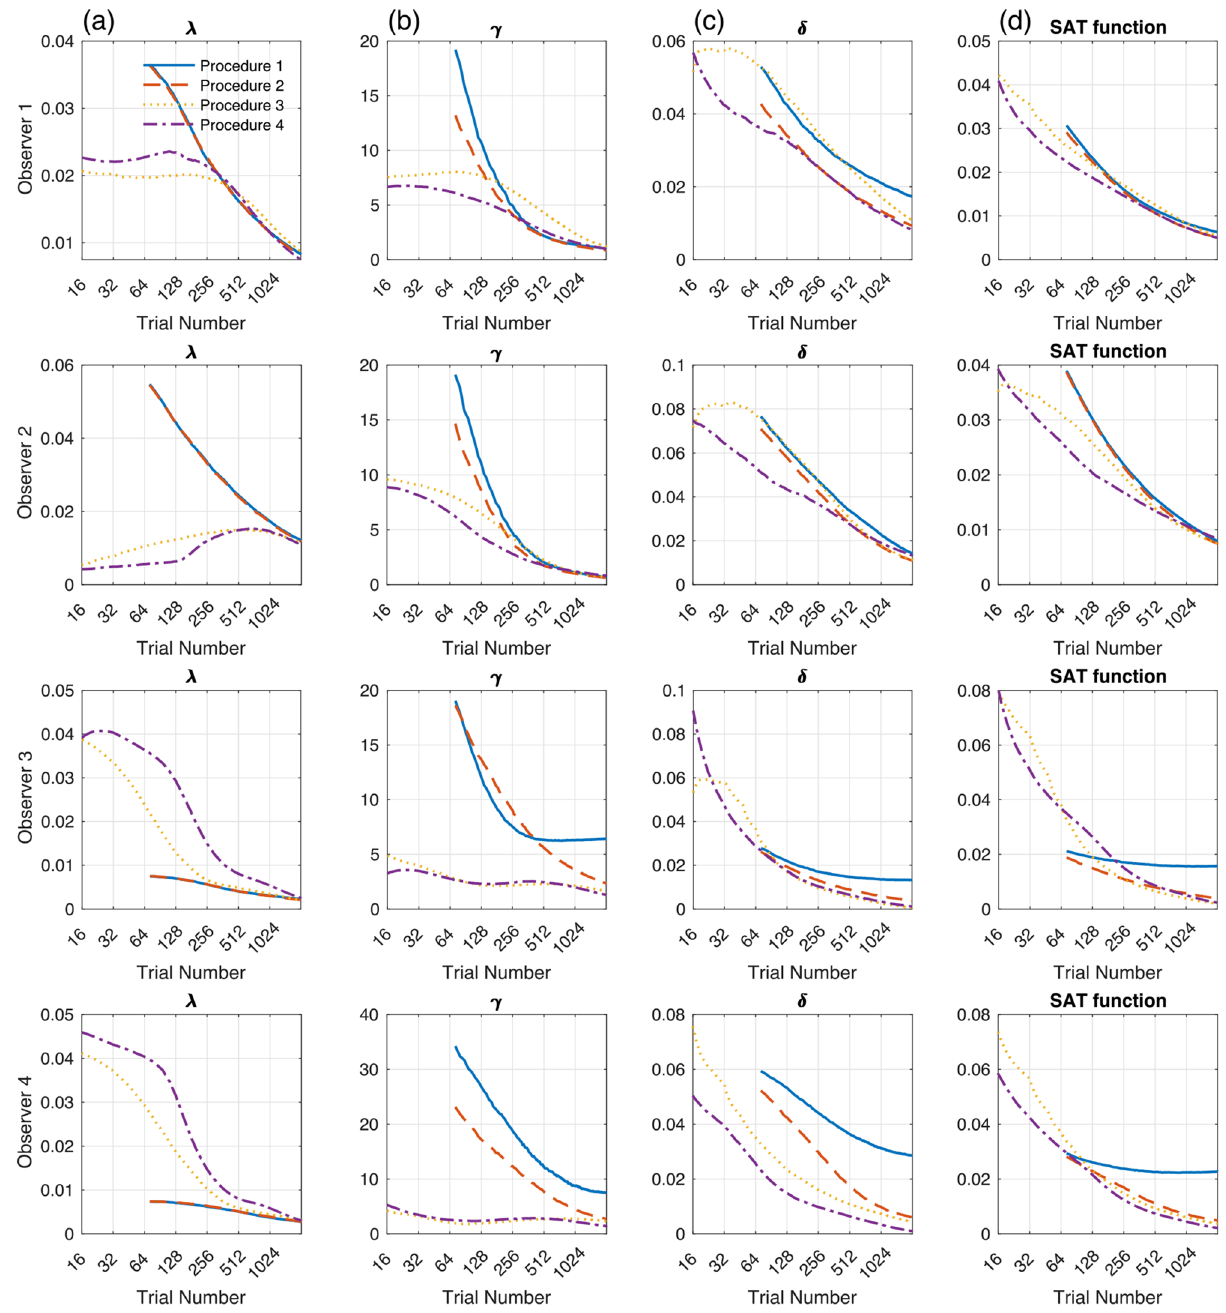
Figure 5. The accuracy of estimated SAT parameters and function with four estimation procedures for four simulated participants. The bias (mean absolute difference between true and estimated parameters) of ( a ) λ, ( b ) γ, and ( c ) δ was plotted as a function of trial numbers. In each panel, different procedures were presented with different colors. Procedure 4 showed better or equivalent accuracy (more negligible bias) than the other procedures, except λ for participants 3 and 4. ( d ) Mean absolute difference between true and estimated SAT function was also smaller with Procedure 4 than with the other procedures. ( Note. Procedure 1: Maximum likelihood estimation with mean RT and accuracy; Procedure 2: Maximum likelihood estimation with trial- by-trial RT and accuracy; Procedure 3: Bayesian estimation without optimal stimulus selection; Procedure 4: Bayesian adaptive estimation with optimal stimulus